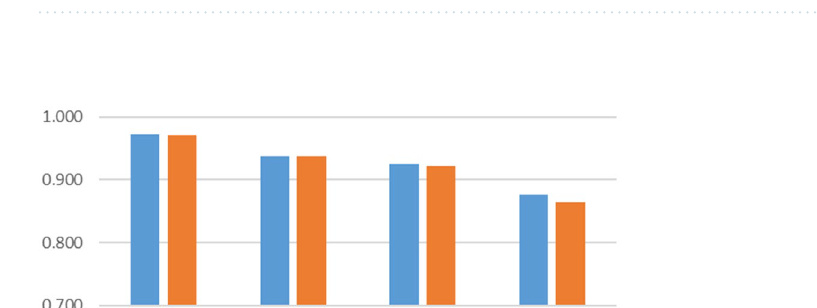
Figure 9. Actual and ANN predicted Poisson’s ratio for ( a ) training ( b ) testing and ( c ) validation.